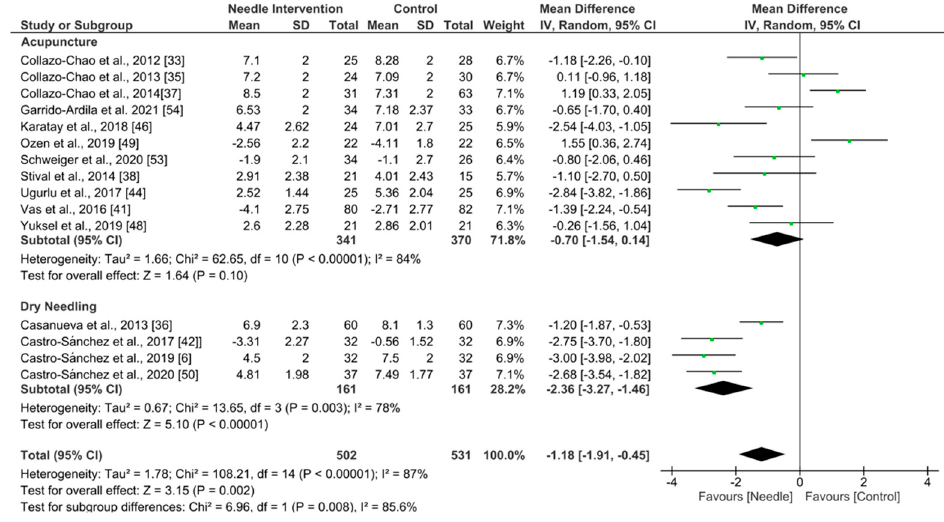
Figure 2. Forest plot for Pain Intensity after 0 – 3 months.